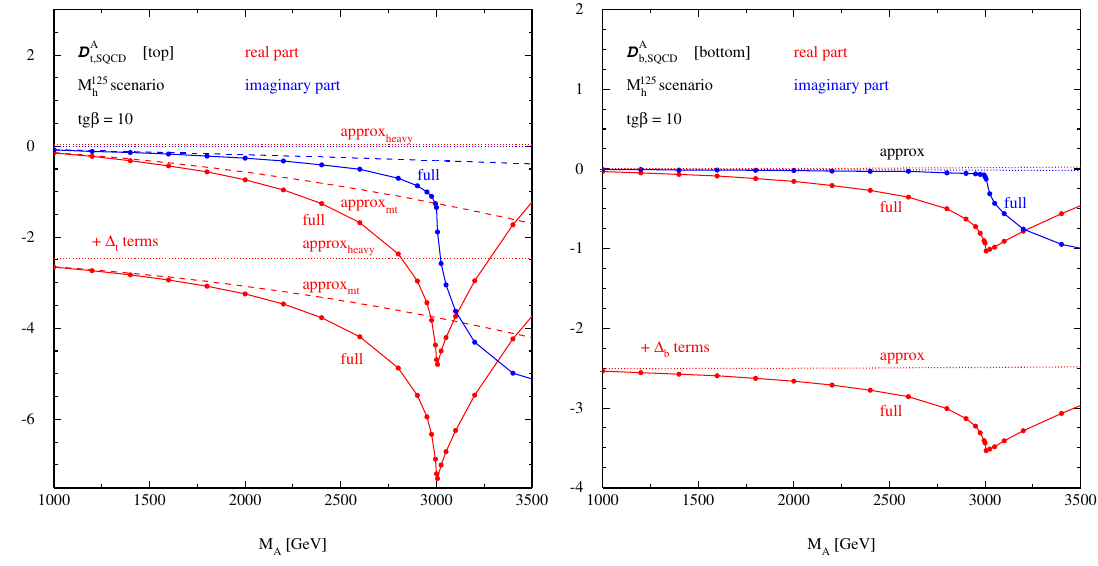
Figure 13 . The genuine SUSY-QCD corrections to A → γγ normalized to the LO top and bottom quark form factors for tg β = 10 in the M 125 benchmark scenario. Real part: red, imaginary part: h blue, compared to the Abelian part of the approximate calculations of ref. [75] (dashed lines). The dotted lines for the stop contributions correspond the combined limit of large top and SUSY